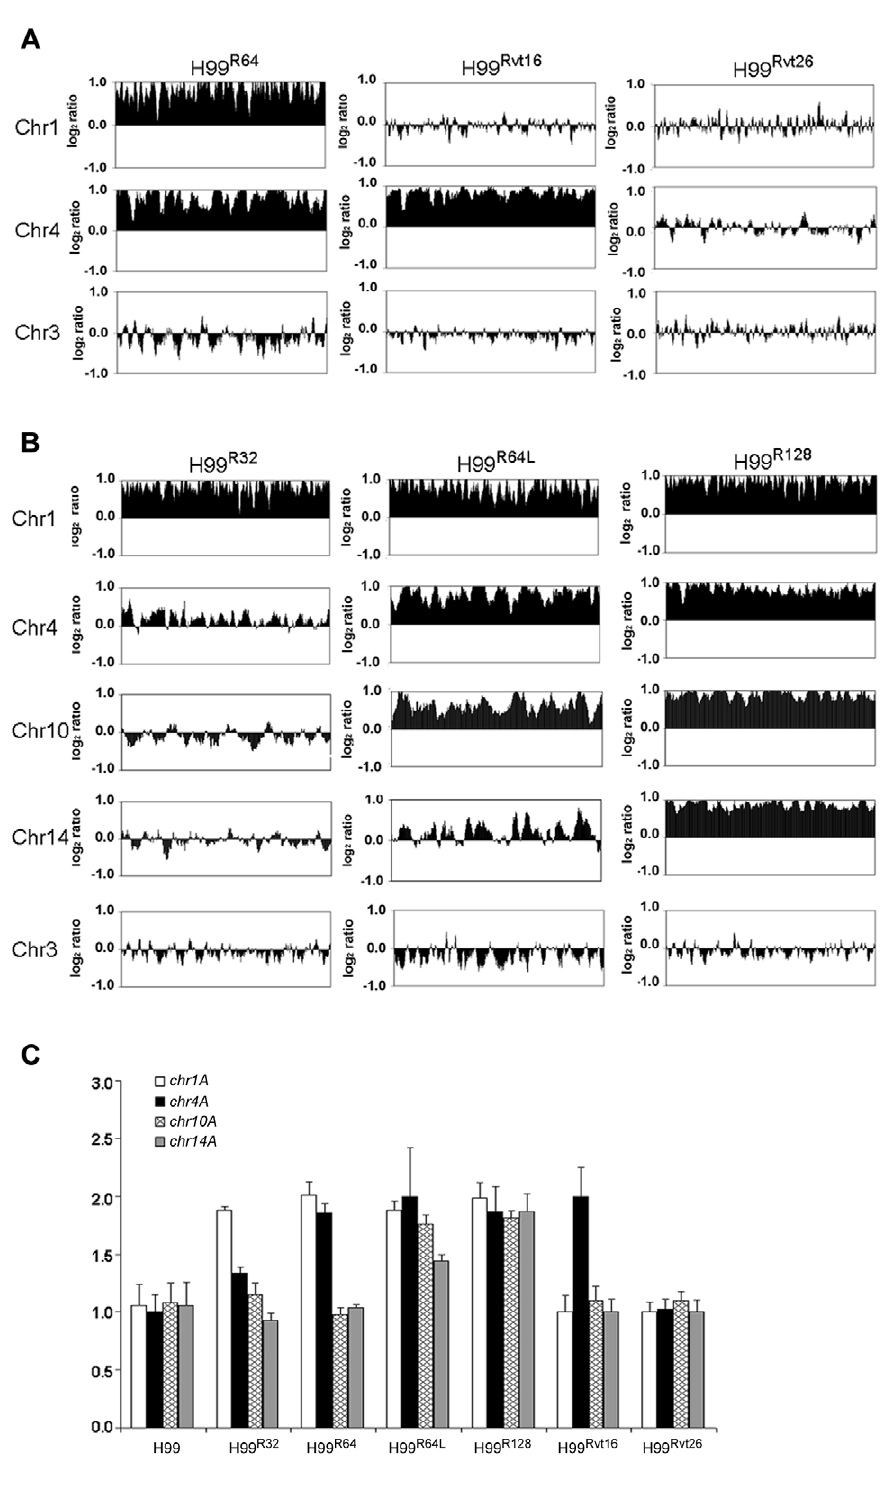
Figure 3. Gain and loss of FLC resistance positively correlates with the number of chromosomes duplicated. ( A ) CGH plots of Chr1, 4, and 3 for strains H99 R64 , H99 Rvt16 , and H99 Rvt26 . ( B ) CGH plots of Chr1, 4, 10, 14, and 3 for strains H99 R32 , H99 64L , and H99 R128 . ( C ) Copy number of four genes in H99-derived strains with different levels of resistance. The relative gene copy number of four probes ( chr1A , chr4A , chr10A and chr14A ) located on Chr1, 4, 10, and 14 was compared to the control probe ( chr3A ) on Chr3. The same genomic DNA from the strains used for CGH arrays was used for qPCR assays. Only the chromosomes involved in duplication are shown. Chr3 serves as a non-duplicated chromosome control.